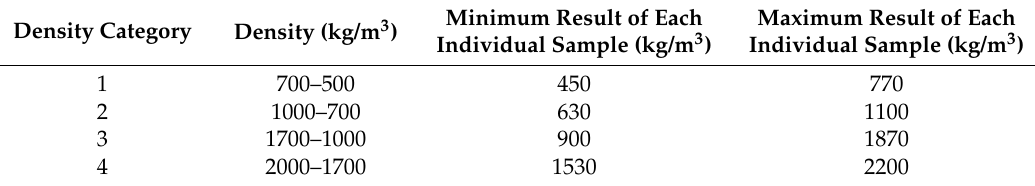
Table 11. Density classification of cement blocks in accordance with ISO 7782 style.